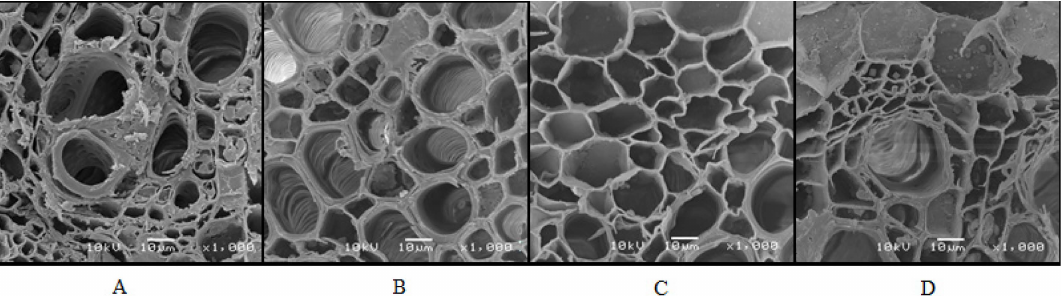
Figure 4. Images zoomed at 1000 × of the inner interveinal structure of the leaves in the CT ( A ), CaCO 3 ( B ), GR ( C ), and PCM ( D ) treatments. CT = Control, GR = Coffee grounds biochar, and PCM = Coffee parchment biochar.